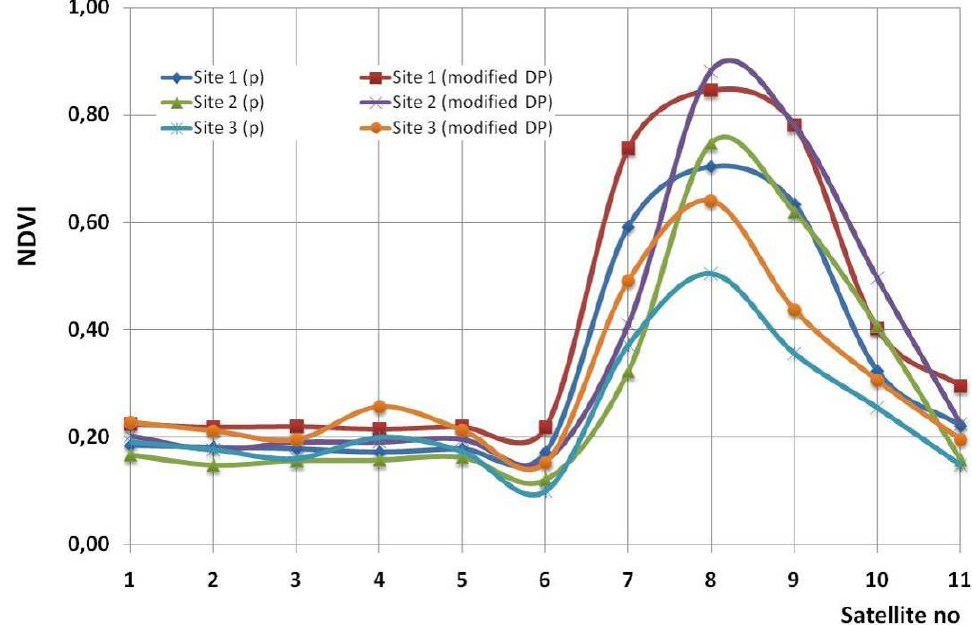
Figure 4. NDVI values for Site 1 and Site 2 using: (a) reflectance values and (b) after the modified DP algorithm reflectance values were applied.